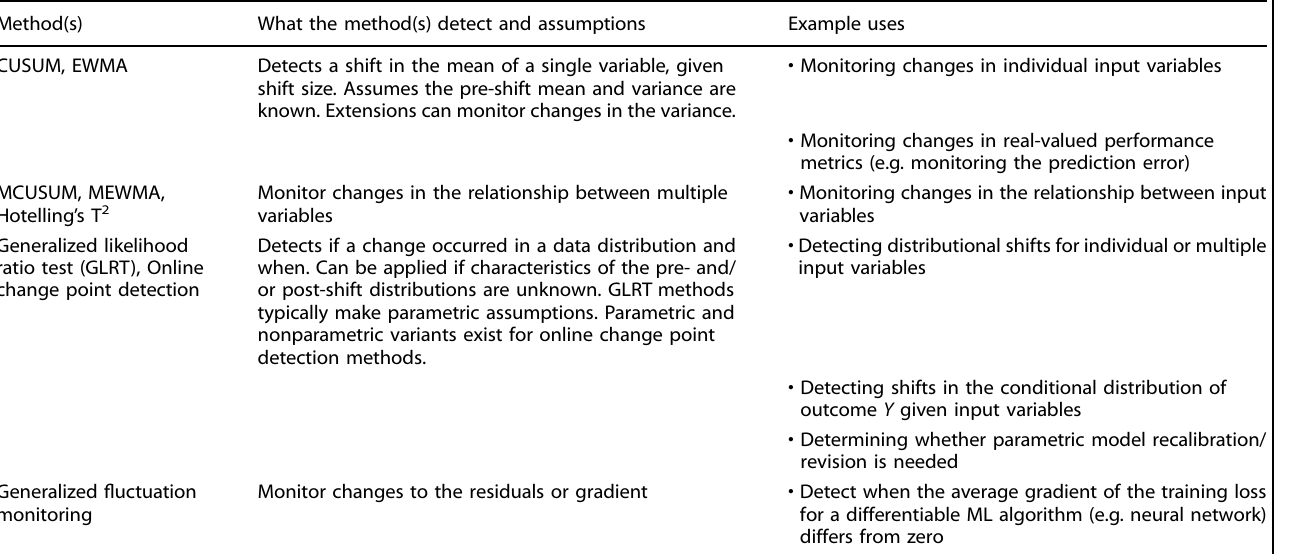
Table 1. Methods from statistical process control (SPC) and their application to monitoring ML algorithms.